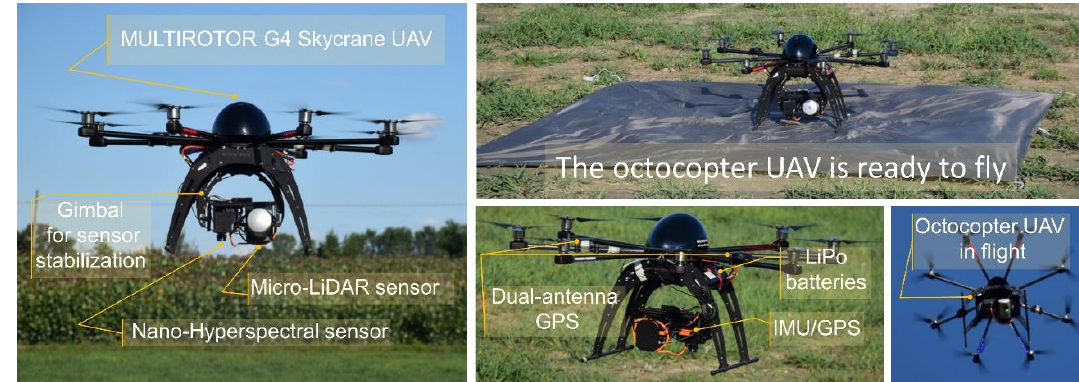
Figure 2. The unmanned aerial vehicle (UAV) platform used for field phenotyping of Arundo donax on the ground and in flight.